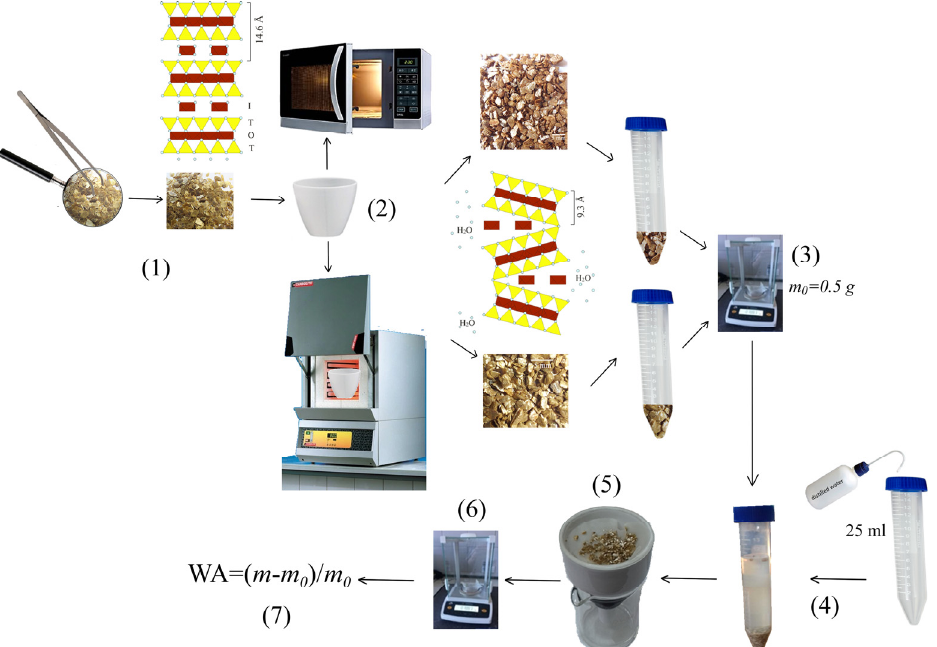
Figure 3. Illustration of the water immersion experiment of the vermiculite. ( 1 ) Cleaning of vermiculite by hand-picking of minerals other than vermiculite. ( 2 ) Vermiculite expansion by heating in an electric furnace at different temperatures and by microwave irradiation. ( 3 ) Weight of 0.5 g of expanded vermiculite ( m 0 ). ( 4 ) Immersion of expanded vermiculite in 25 mL of distilled water during different times. ( 5 ) Filtered and dried at room temperature (20 ◦ C) of vermiculite. ( 6 ) Weight of vermiculite ( m ). ( 7 ) Obtaining